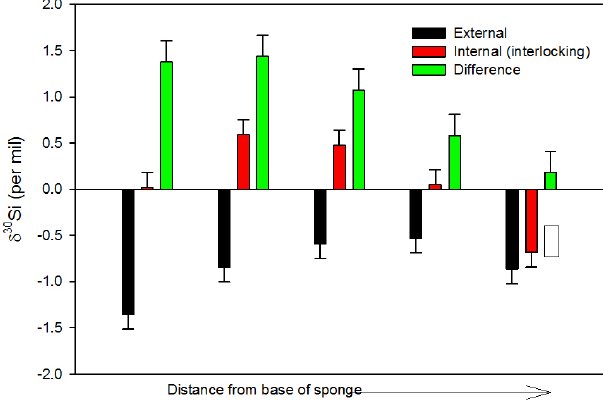
Figure 3. δ 30 Si values for subsamples of DH19-2. Red bars show the internal interlocking framework, black bars show the external loose spicules, and green bars show the difference between the in- ternal and external spicules. Hollow rectangular symbol shows the isotopic composition of individually picked and cleaned styles from the growing tip. Error bars show external reproducibility from repli- cate standard measurements (2SD).